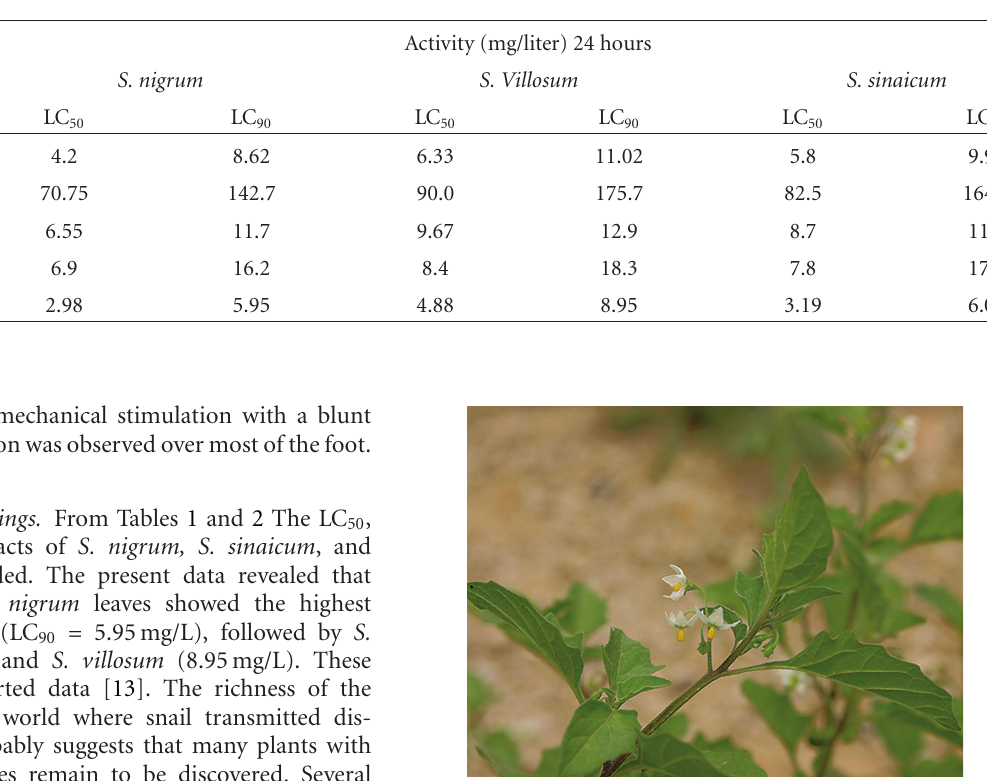
Table 2: LC50 and LC90 for solvent extracts of leaves of S. nigrum, S. villosum , and S. sinaicum against B. alexandrina after 24 hours at room temperature.